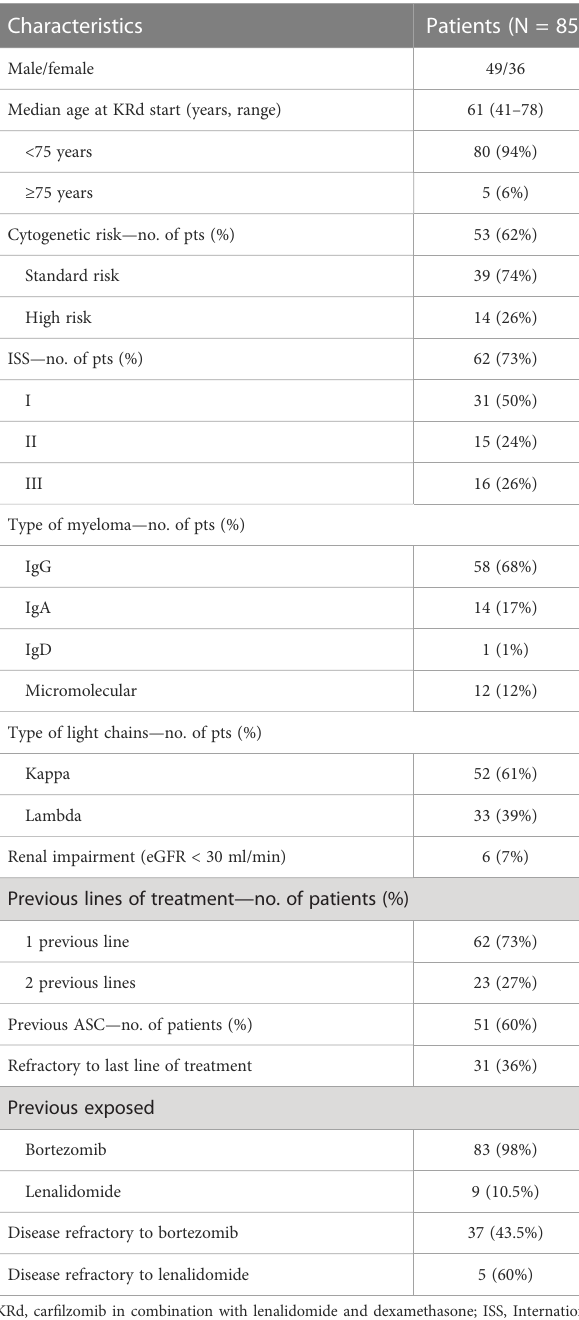
TABLE 2 Responses according to IMWG consensus criteria. TABLE 1 Patients ’ characteristics at KRd treatment.